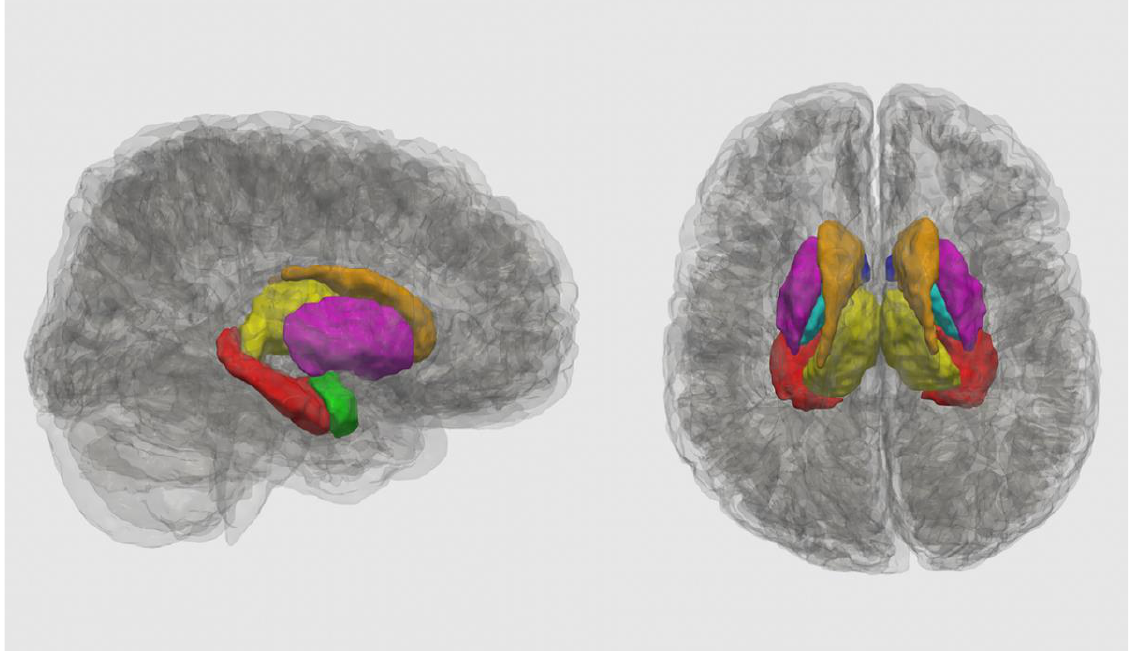
Figure 1. Regions of interest are shown in an unexposed control participant (girl, age 9 y) in a sagittal ( left ) and axial ( right ) 3D mesh reconstruction using ITK-Snap version 3.8.0 (USA) [57]: nucleus accumbens (dark blue), caudate (copper), putamen (pink), pallidum (cyan), thalamus (yellow), hippocampus (red), and amygdala (lime green).